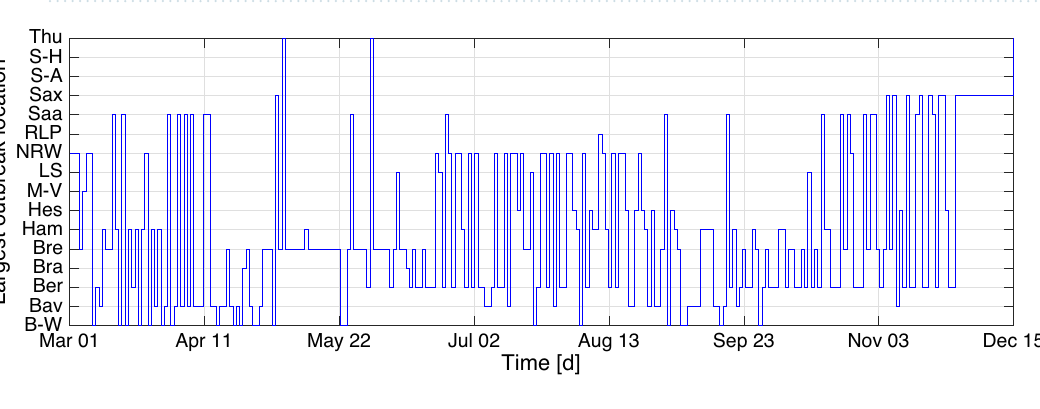
Figure 3. Spatial concurrence of the largest